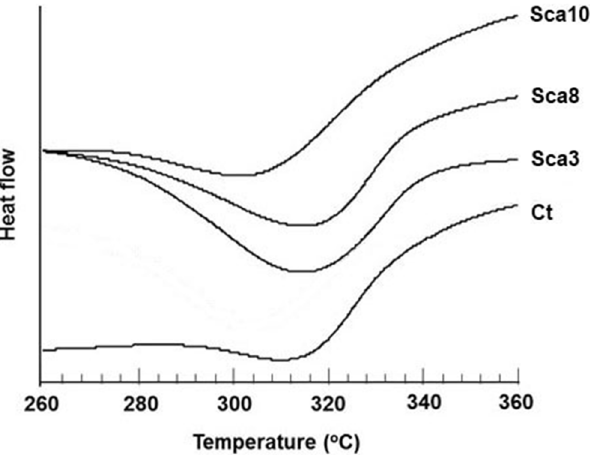
Fig 6. The measurement of the thermal characteristics of the transgenic silk. The exothermic peaks of Sca3, Sca8 and Sca10 appear at 314, 314 and 303°C, respectively.